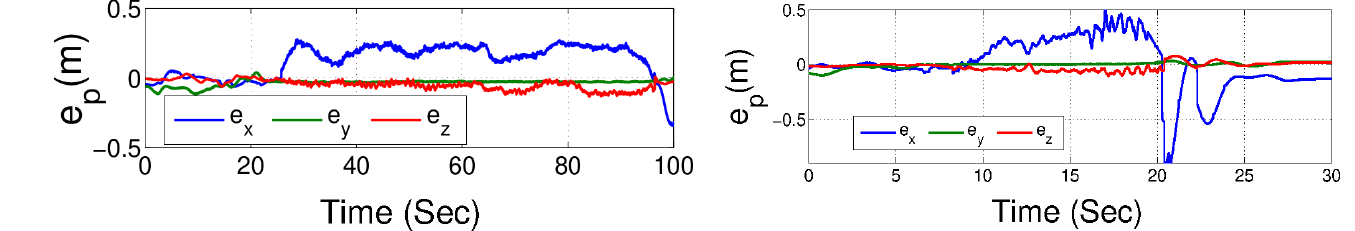
Figure 9. Position error in the stationary object experiment ( left ) and movable object experiment ( right ): as can be seen, the error is bigger during the interaction phase, in both cases, as a consequence of the force tracking. Furthermore, the error is higher in the movable object experiment, in particular during the undocking phase.